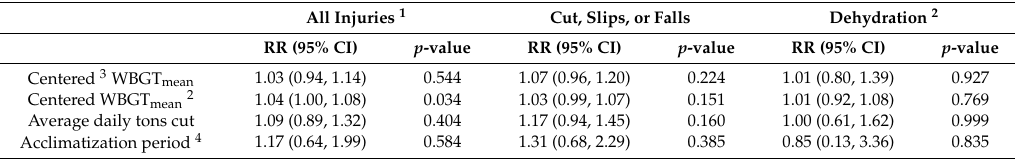
Table 4. Estimated Risk Ratios (RR) for reported occupational injuries and confirmed dehydration cases among sugarcane harvesters in Southwestern Guatemala—2014–2018. All models adjusted for total number of workers and harvest